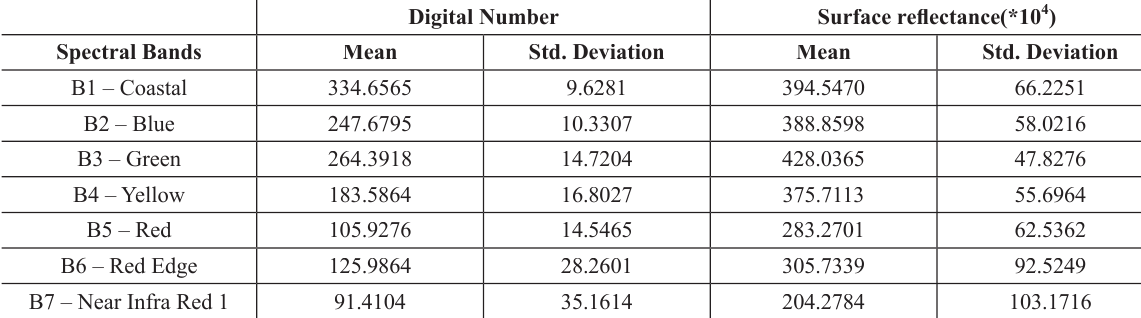
Basic statistics of Cascata’s reservoir spectral attributes.